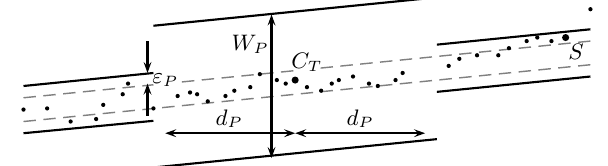
Figure 3. Trend pinching procedure (in step 2).